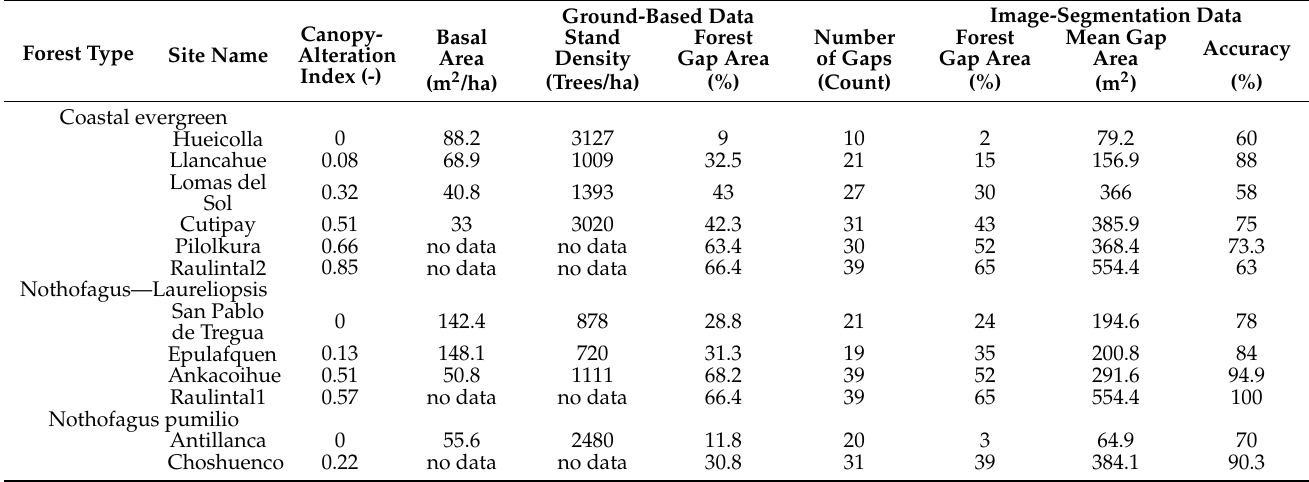
Table 2. The forest canopy gap structure of the stands studied in the Valdivian ecoregion. Accuracy refers to the percentage of ground-detected canopy gaps identified remotely using very high-resolution